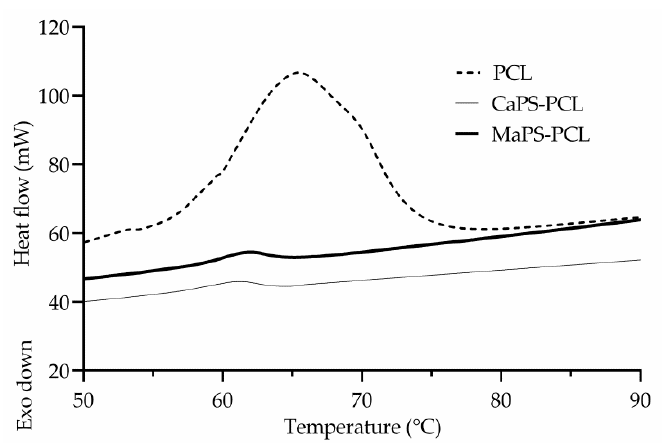
Figure 3 . DSC thermograms of PCL, CaPS–PCL, and MaPS–PCL. Figure 3. DSC thermograms of PCL, CaPS–PCL, and MaPS–PCL.